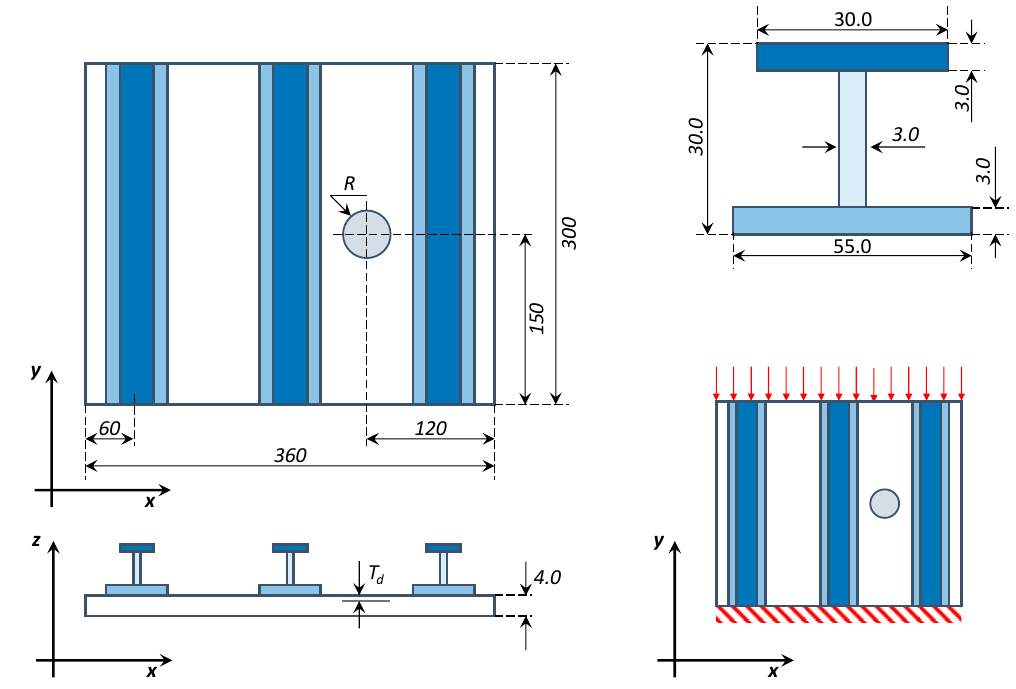
Figure 13. Test case 2 geometrical description (dimensions in mm) and boundary conditions. Table 3. T800/924 material properties.